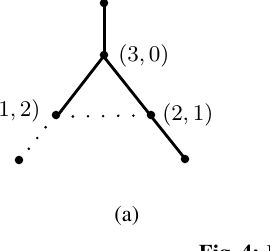
Fig. 4: Possible colorings of I ′